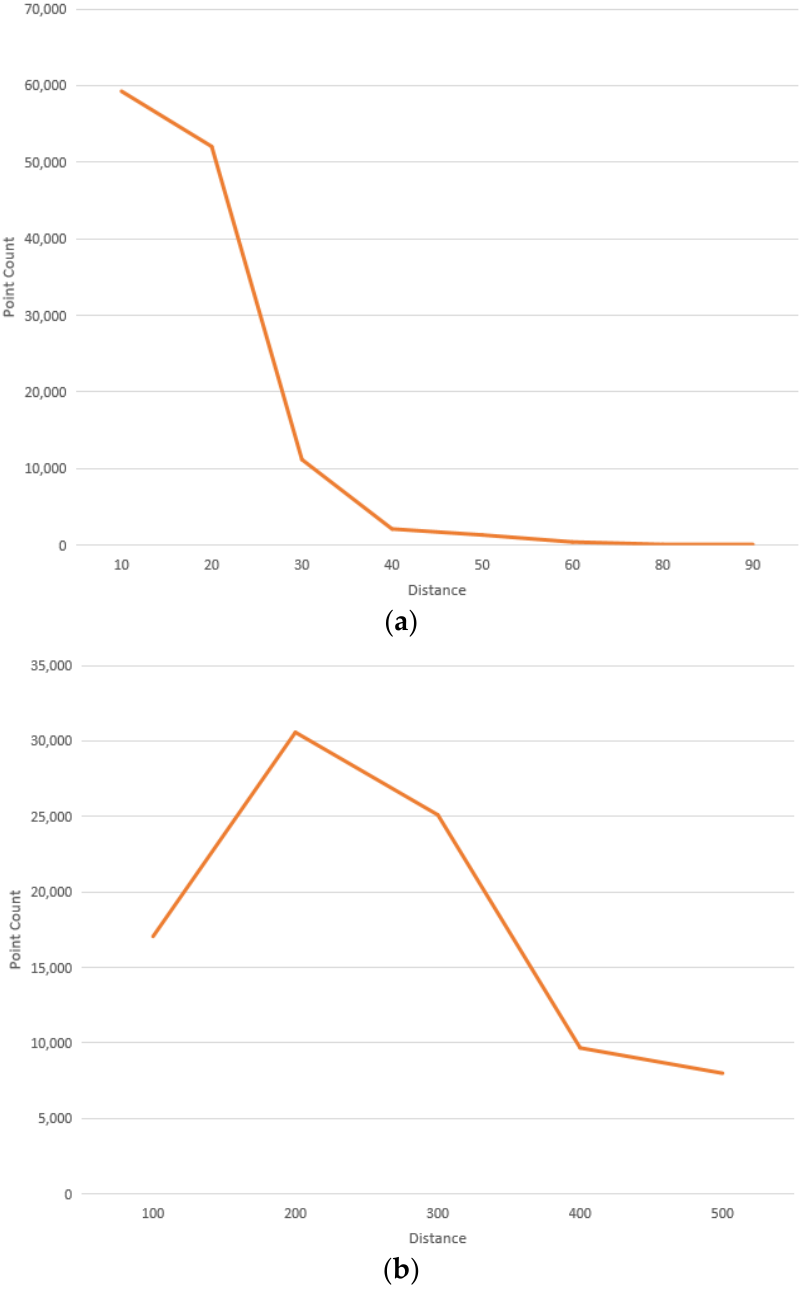
Figure 1. Density distributions of LiDAR point clouds in the Cartesian and polar BEV coordinate systems, where the x - and y -axes indicate distance and point count, respectively: ( a ) Cartesian coordinate system; ( b ) polar BEV coordinate system.